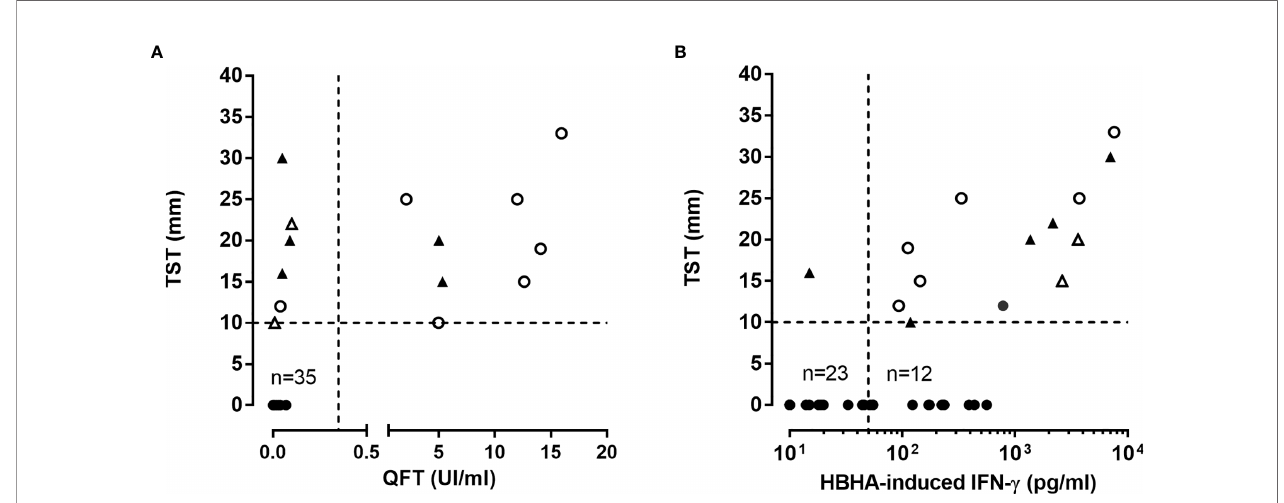
FIGURE 2 | Correlation between immunoassays performed in psoriatic patients. (A) TST and QFT results were compared in all patients. Triangles represent patients who received anti-TB prophylaxis, open symbols represent patients with a past anti-TB treatment. (B) TST and HBHA-IGRA results were compared in all patients. Triangles represent patients who received anti-TB prophylaxis and open symbols (triangle or circle) represent QFT + patient. TST results are given as the size of induration in mm, QFT results are expressed in international unit (UI) of IFN- g par ml of blood, and HBHA-IGRA results are reported as concentration of IFN- g (pg/ml) released in 24 h culture supernatants of PBMC incubated with HBHA.